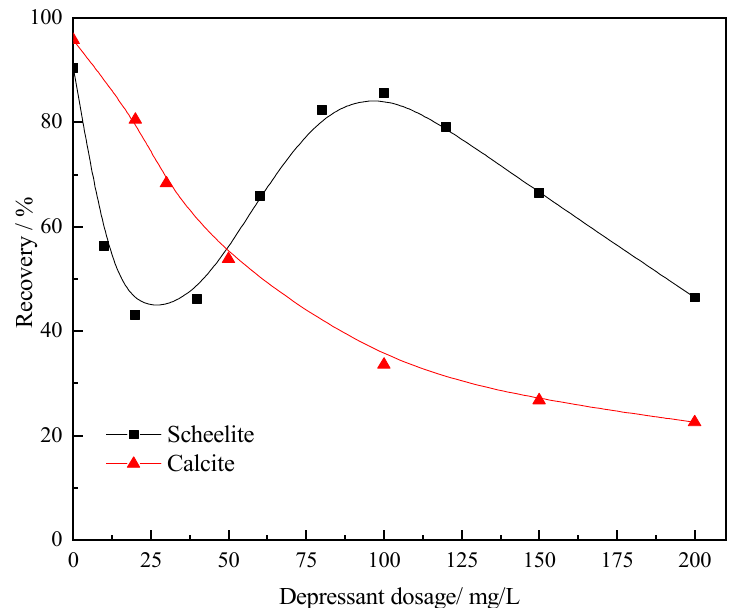
Figure 1. Effect of Al-Na 2 SiO 3 polymer dosage on scheelite and calcite flotation (pH = 9.0 ± 0.1, C lead ion = 3 × 10 − 4 mol/L, C BHA = 1.5 × 10 − 4 mol/L, C terpineol = 12.5 μ L/L).